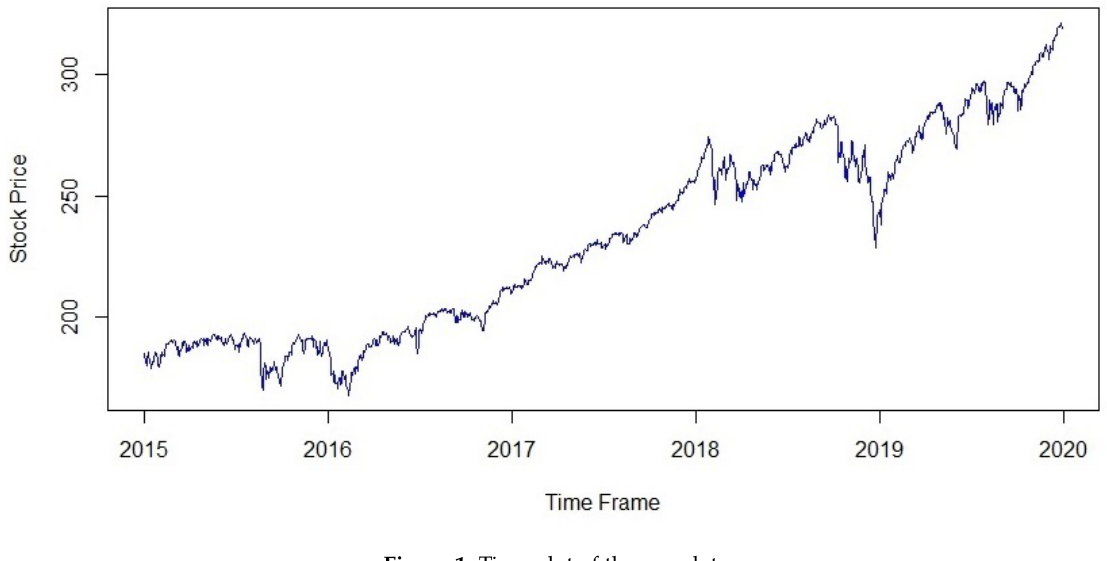
Figure 1. Time plot of the raw data.